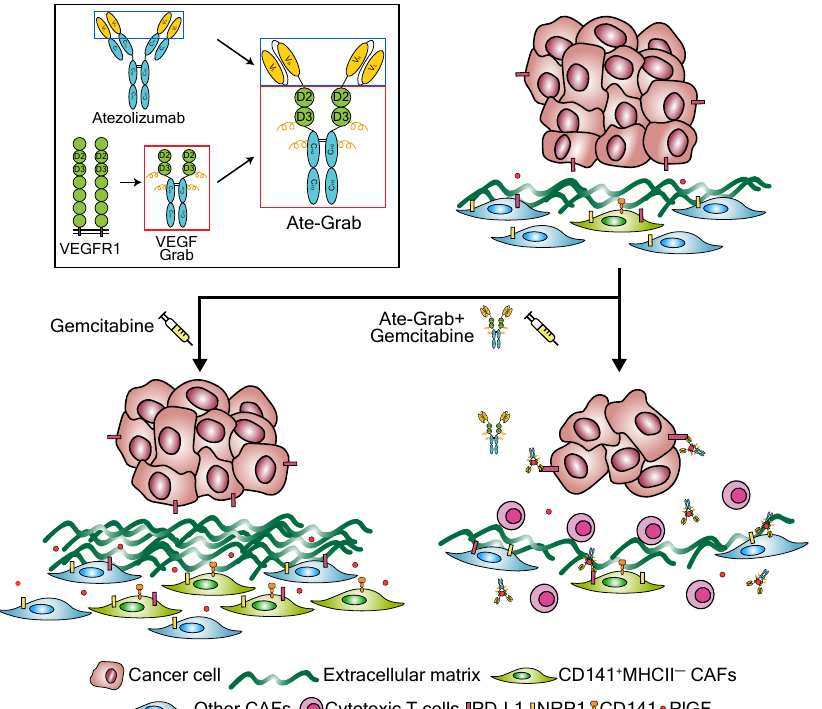
Fig. 9|Modeofaction ofAte-Grab withinthetumormicroenvironment(TME). The functional effects of Ate-Grab in the pancreatic tumor microenvironment are brie fl y summarized and illustrated. We developed a multi-paratopic-VEGF decoy receptor,dubbed “ Ate-Grab, ” byfusingthesingle-chainFvofatezolizumab(ananti- PD-L1 antibody) to the N-terminus of VEGF-Grab. Ate-Grab treatment blocked and